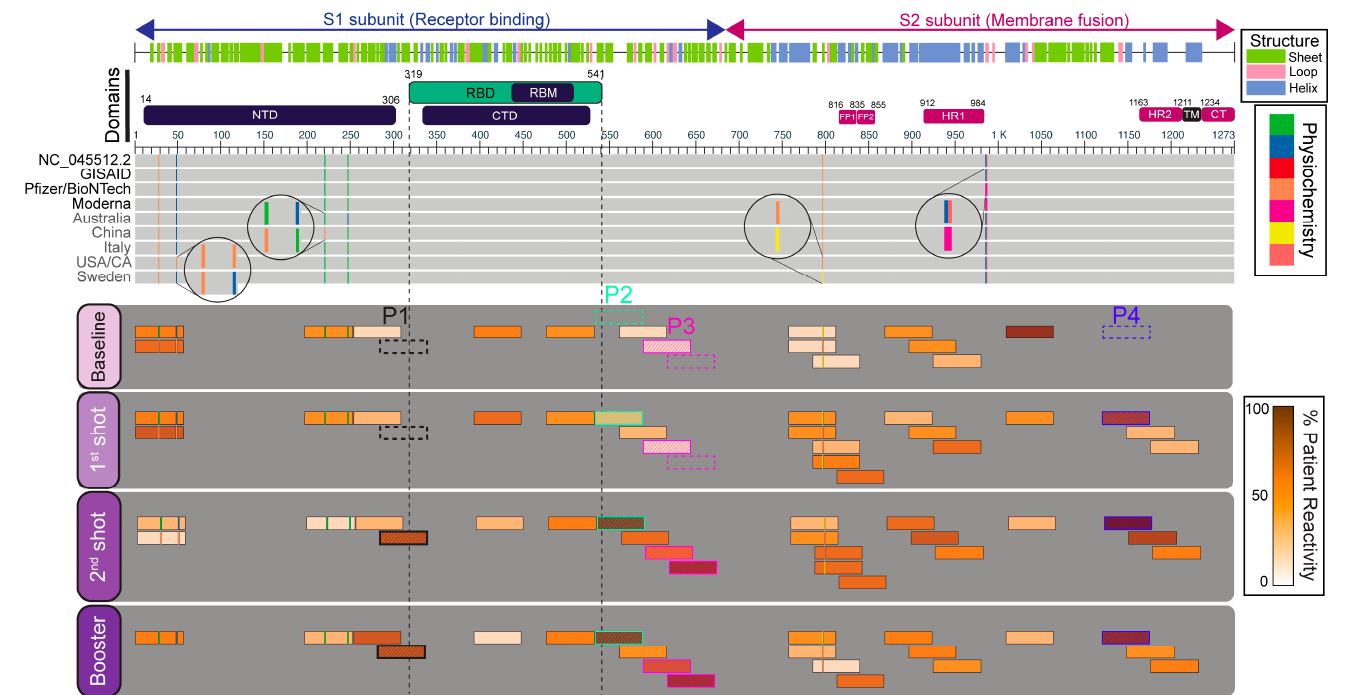
Figure 2. Epitope map of anti-S responses represented as percent subject reactivities. The multiple sequence alignment (MSA) of full-length SARS-CoV-2 spike glycoprotein reference, vaccine, and input library sequences are shown, where regions in light grey represent sequence conservation. Mismatched residues are highlighted and color-coded using the pre-defined Zappo scheme (green: hydrophilic, salmon: aliphatic/hydrophobic, orange: aromatic, fuchsia: conformationally special, yellow: cysteine only, red: negatively charged, blue: positively charged). Reactive peptides are mapped and colored based on % subject reactivity (brown gradient) across timepoints. Vaccine- boosted epitopes are indicated (P1–P4). Peptides with transparent backgrounds and dashed borders indicate absence of baseline responses and are only shown for convenience. Abbreviations: NTD: N-terminal domain, CTD: C-terminal domain, RBD: Receptor-binding domain, RBM: